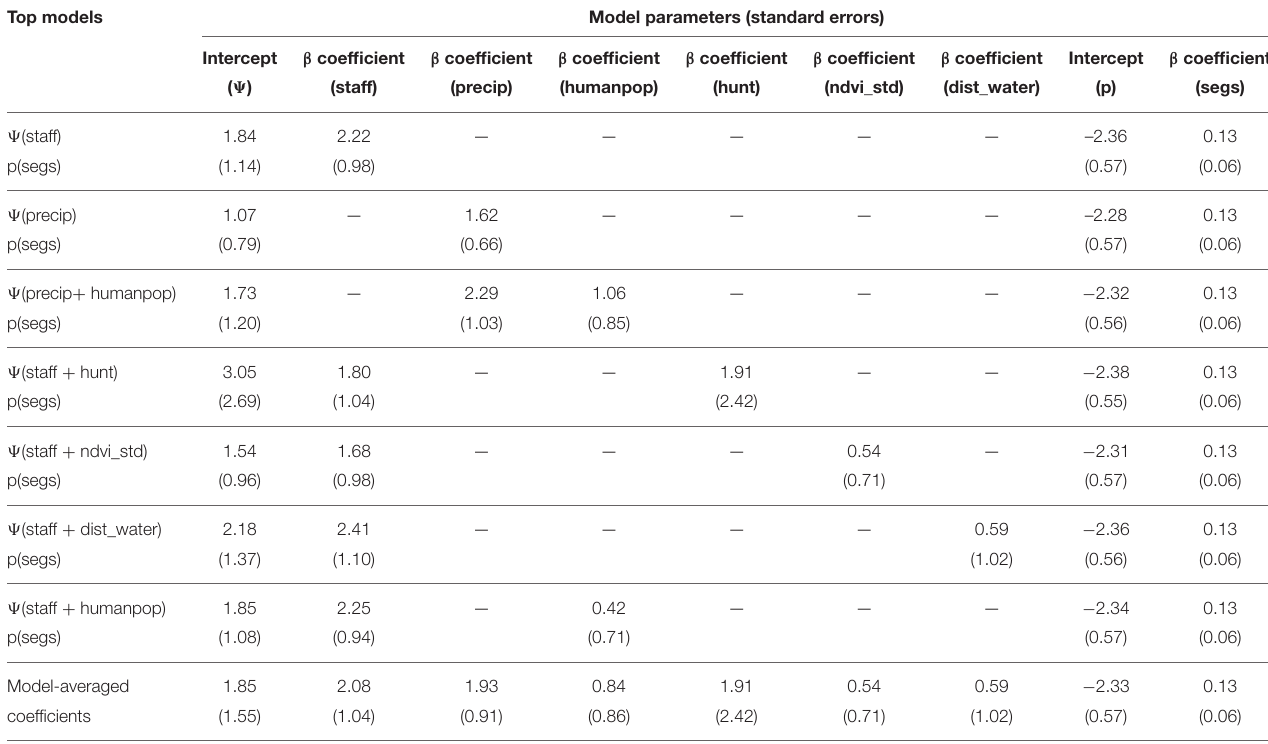
TABLE 4 | Parameter estimates (standard errors in parentheses) of final model set for estimating lion occupancy ( 9 ) in WAP. Top models